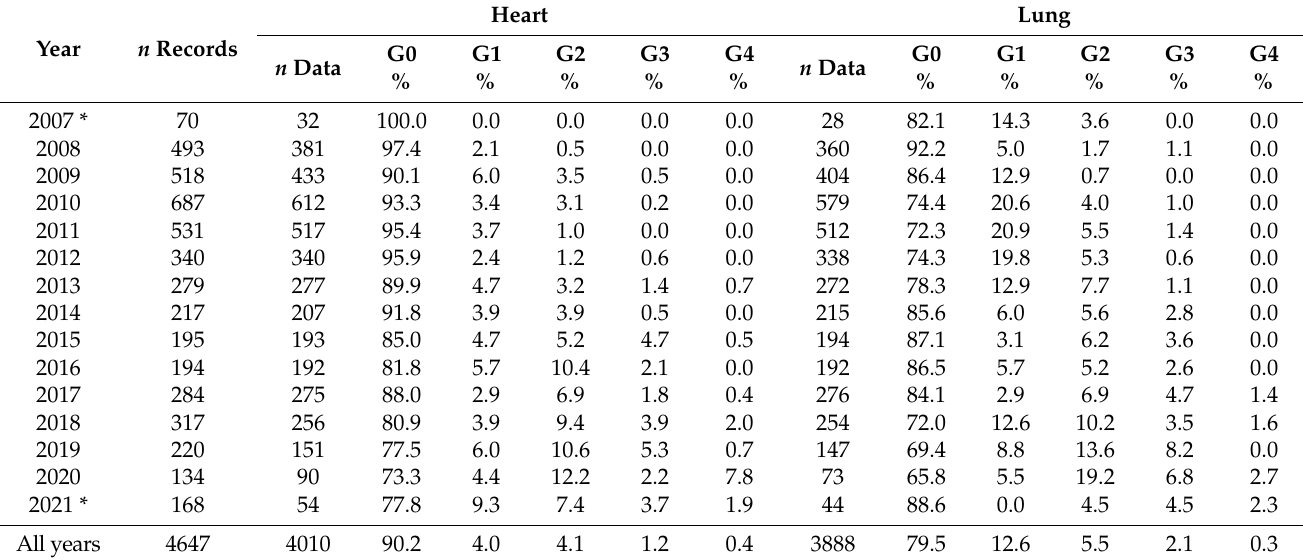
(Table 3, bottom row). However, when compared by calendar year, gradual changes in the incidence of toxicities were observable. Table 3. Heart and lung toxicities. G0, no toxicity. G1–G4, toxicity Grade 1–4. * Half-year